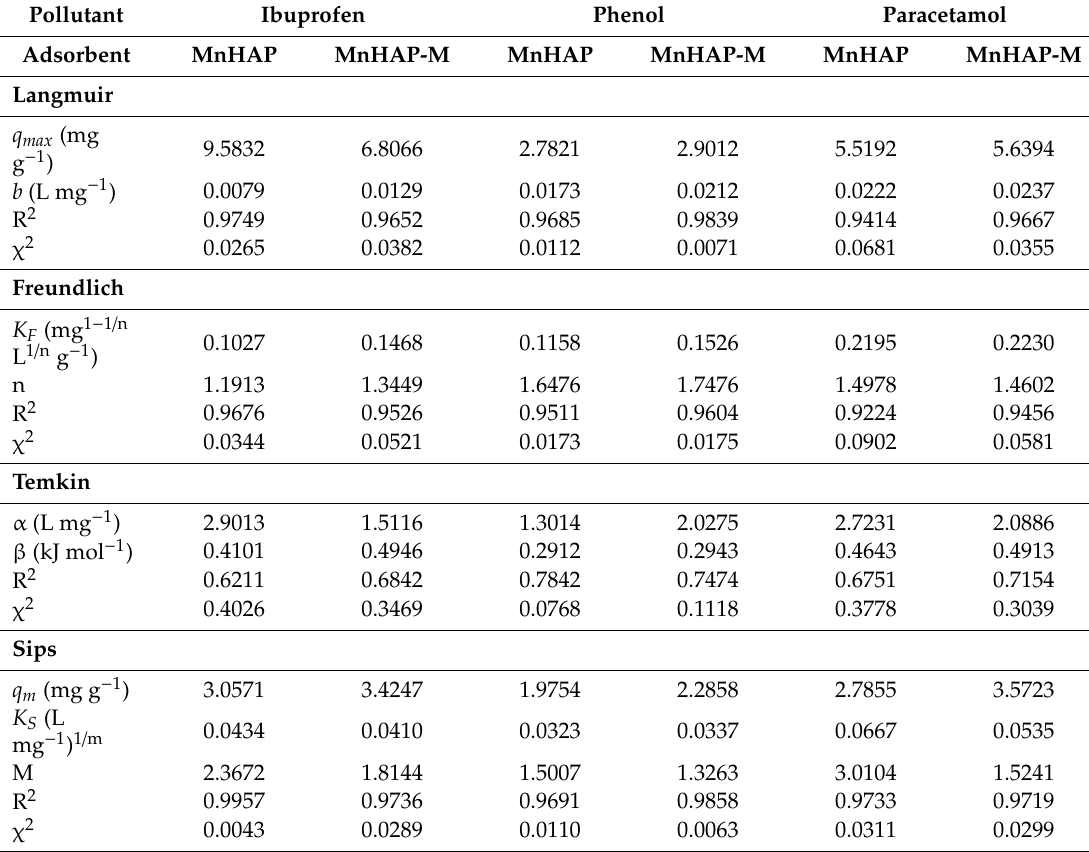
Table 3. Parameters obtained from the Langmuir, Freundlich, Sips, and Temkin